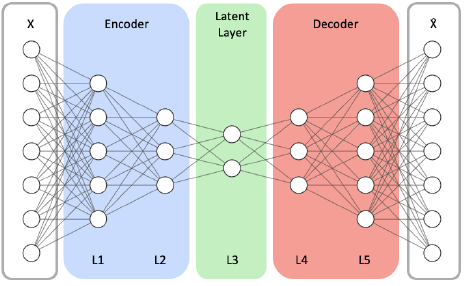
Figure 3. An example autoencoder model architecture with symmetrical encoder and decoder networks. X and ˆ X respectively represent the model’s input and its reconstructed